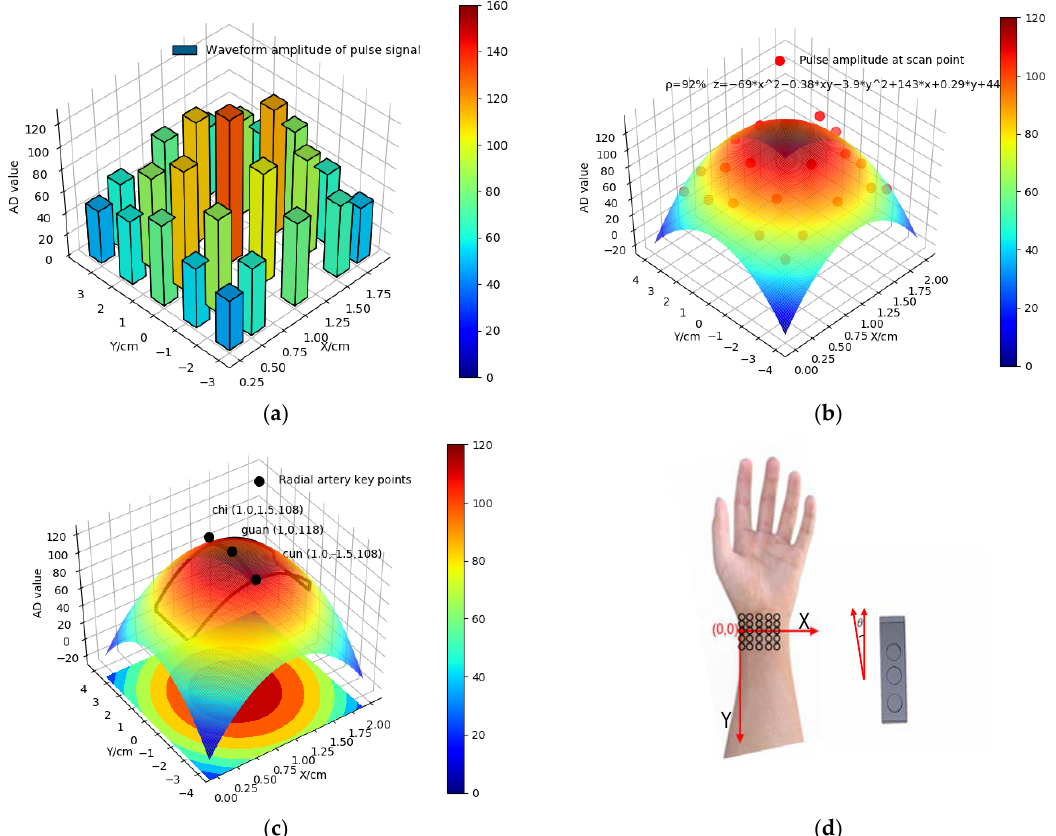
Figure 4. The principle of adaptive pulse finding. ( a ) Scan of fixed positions of the wrist; ( b ) the relationship between amplitudes and positions of the pulse signal; ( c ) radial artery key points loca- tion; and ( d ) deployment of the sensor array.